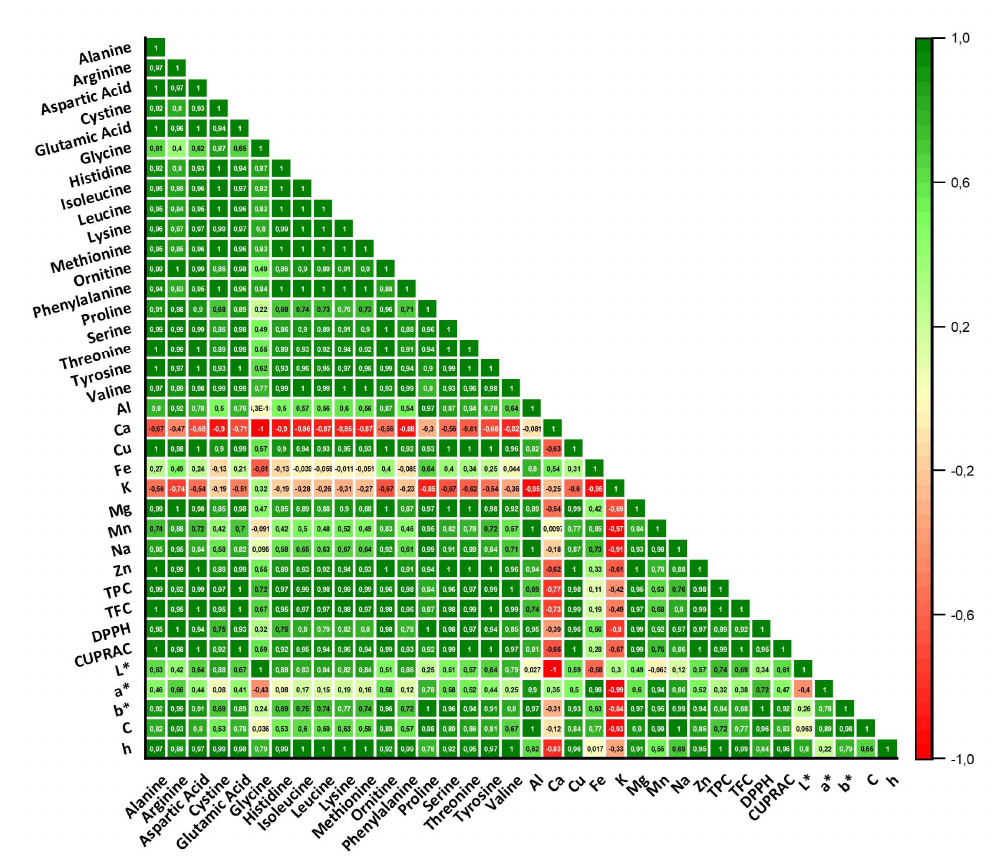
Figure 6. Pearson’s correlation coefficients of bioactive compounds, amino acids, and mineral and color values of tangerine juice samples.